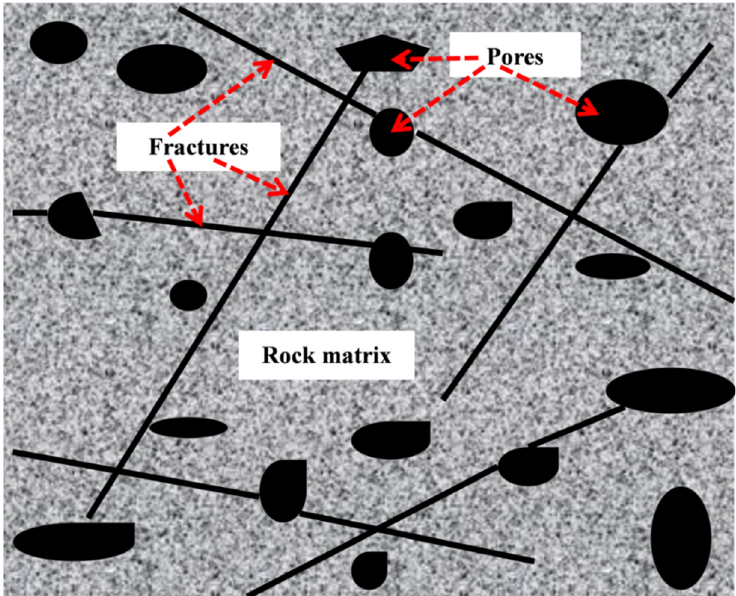
Figure 1. The cross-section structure diagram of the representative elementary volume of the fracture network.